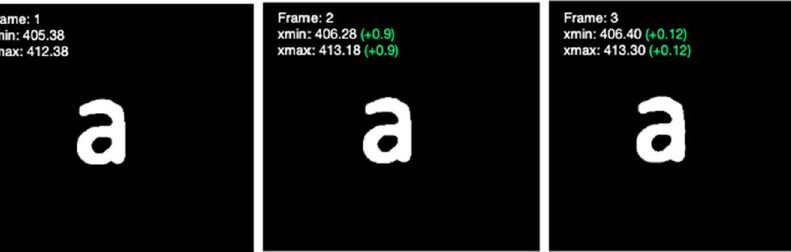
Fig. 9 KUnits on different frames with similar coordinates (same